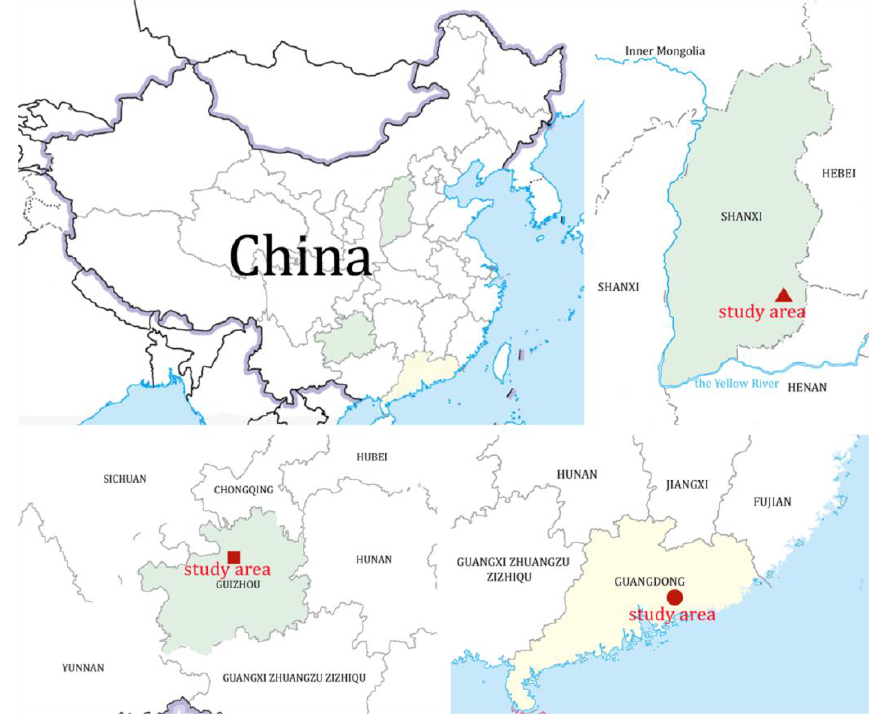
Figure 1. Map of general collection locations of the samples investigated in this study. More detailed information on the collection of the Synura specimens is provided in Table 1. Table 1. Collection information and voucher numbers for taxa analyzed in this study. Locality with Longitude Isolate and